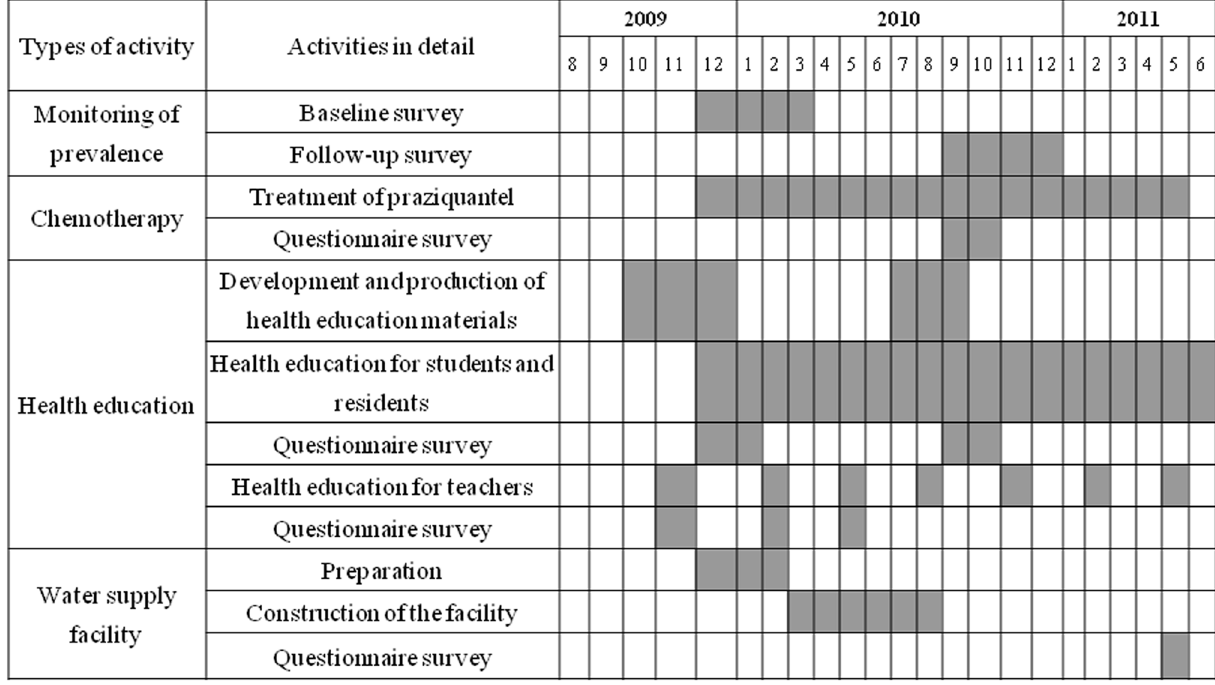
Fig. 4. Implementation schedules of chemotherapy, health education, and construction of water supply facility. To evaluate the prevalence of S. haematobium and S. mansoni infection, baseline survey was implemented at 61 primary schools in Al Jabalain locality before treatment, and the follow-up survey was conducted at 6–9 months after the chemotherapy. Chemotherapy and health education for students and residents were carried out through the whole project period. A drinking water supply facility at the Al Hidaib village was completed at August, 2010, and questionnaire survey from residents was done 9 months after completion.